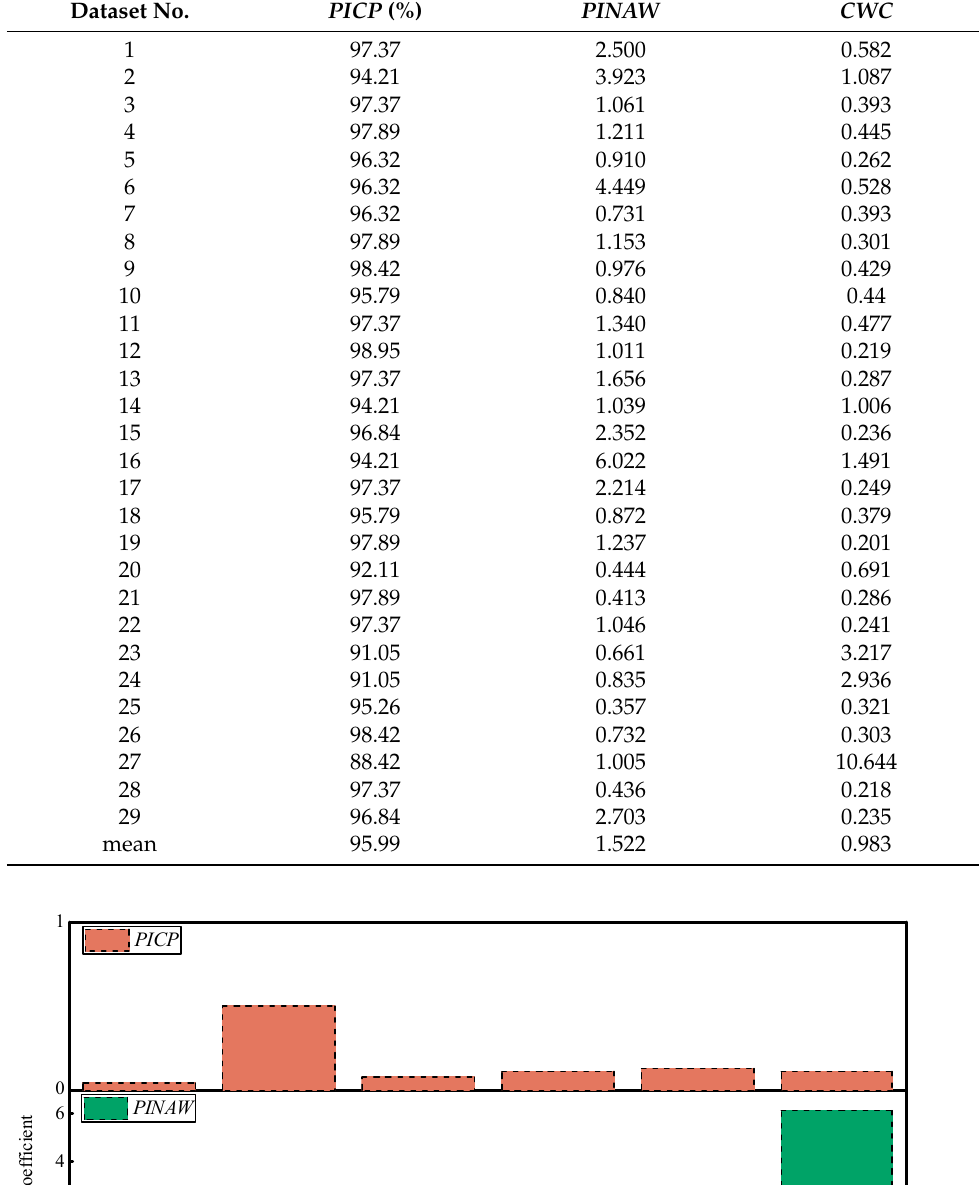
Table 2. PICP , PINAW , and CWC of 29 wind speed sequences.